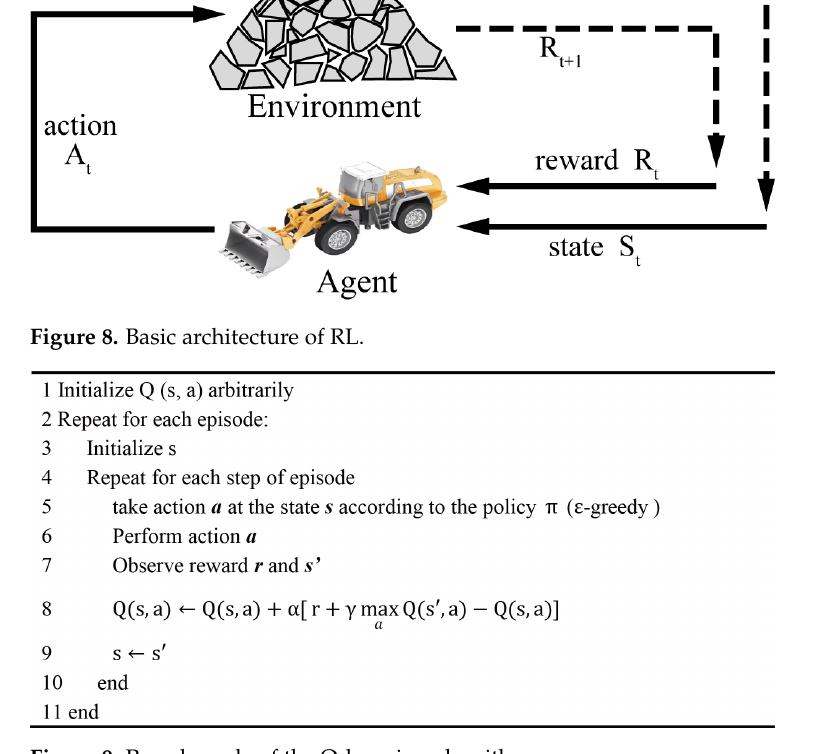
Figure 9. Pseudo-code of the Q-learning algorithm.